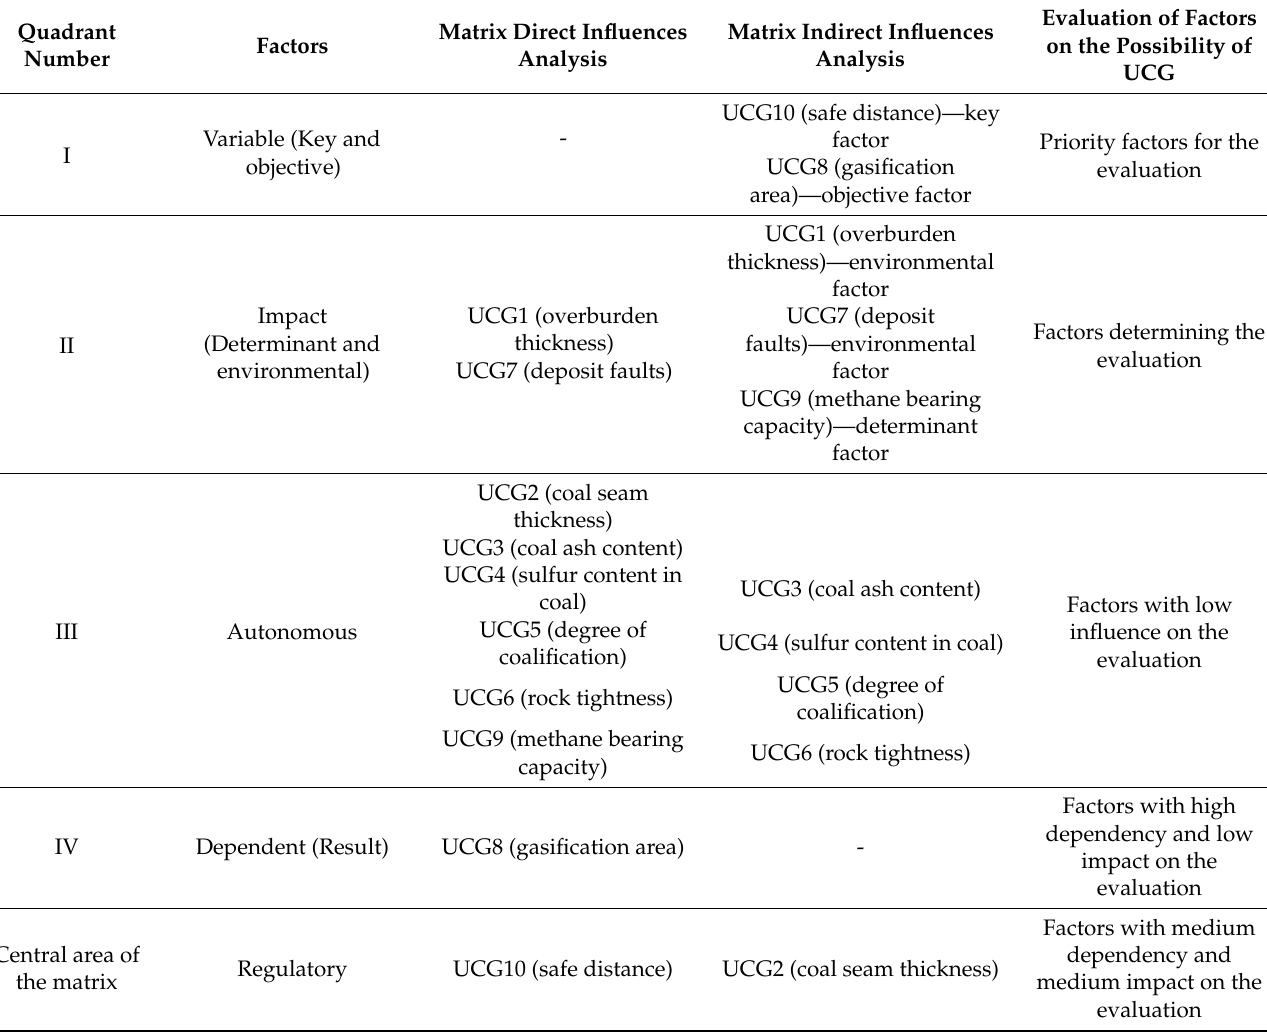
Table 3. Summary of structural analysis using